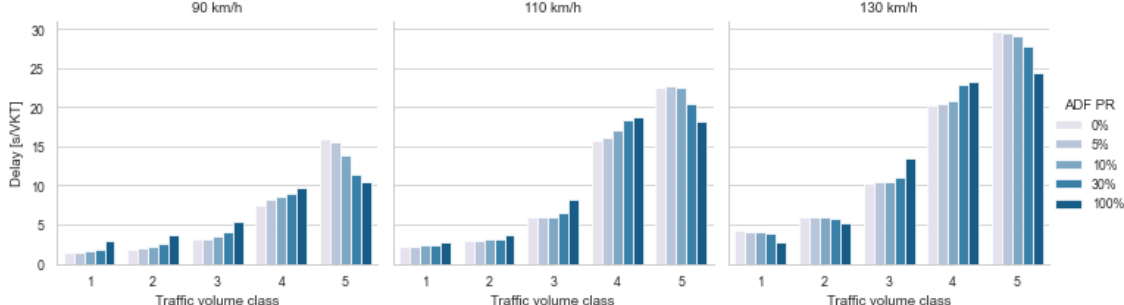
Figure 4. Average delay in seconds per VKT for speed limits of 90, 110 and 130 km/h per traffic volume class and AV penetration rate among passenger cars on EU27+3 motorways. Volume class 1: up to 750 veh/h/lane; 2: 751–1250 veh/h/lane; 3: 1251–1750 veh/h/lane; 4: 1751–2250 veh/h/lane; 5: over 2250 veh/h/lane.